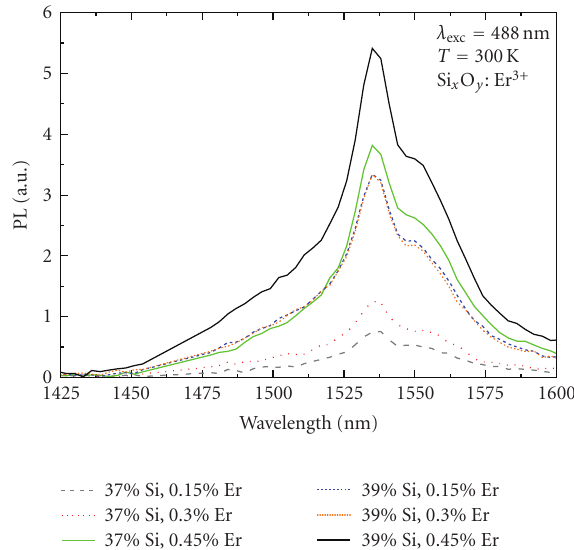
Figure 1: PL spectra of Er 3+ codoped Si x O y films with di ff erent at. % of Si and Er obtained at 488nm excitation wavelength.